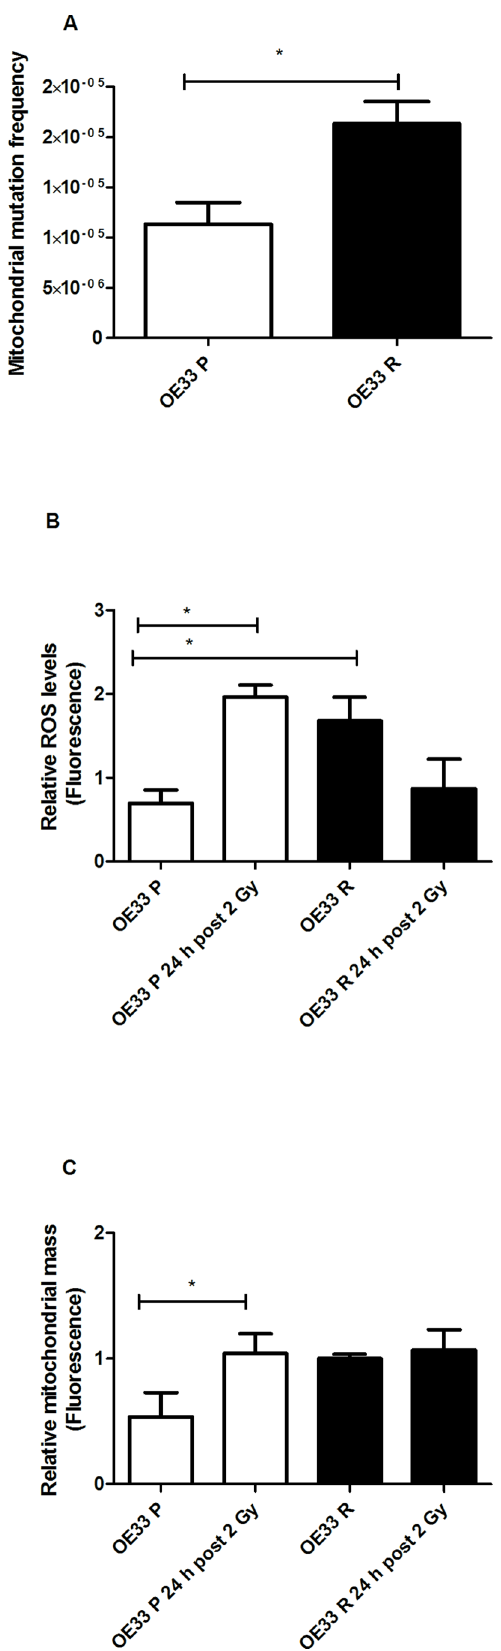
Figure 1. Radioresistant OE33 R cells have increased mito- chondrial mutagenesis and altered mitochondrial function. ( A ) OE33 R cells demonstrate significantly elevated basal levels of random mitochondrial mutations, when compared to OE33 P. ( B ) OE33 R cells have significantly increased basal ROS levels, when compared to OE33 P. ROS levels are significantly increased in OE33 P cells at 24 h post irradiation with 2 Gy. ( C ) Mitochondrial mass is significantly increased in OE33 P cells at 24 h post irradiation with 2 Gy, this effect is not seen in OE33 R. Data are presented as mean 6 SEM from 3 independent experiments. Statistical analysis was performed by 2-tailed Student’s t - test, * P ,